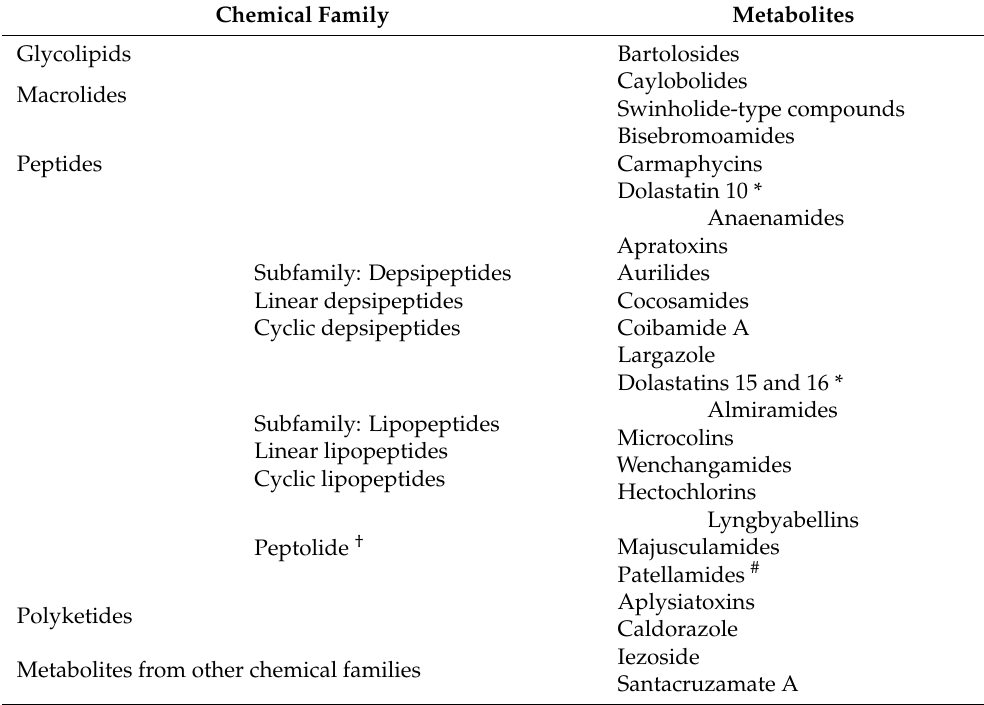
Table 1. Chemical families of cyanobacterial metabolites.